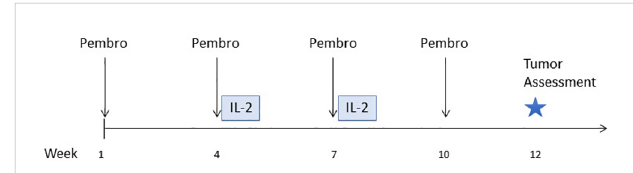
FIGURE 1 Study schema. Treatment began with pembrolizumab only for the fi rst cycle. IL-2 therapy (2 cycles of up to 14 doses each) was given immediately following the second and third cycles of